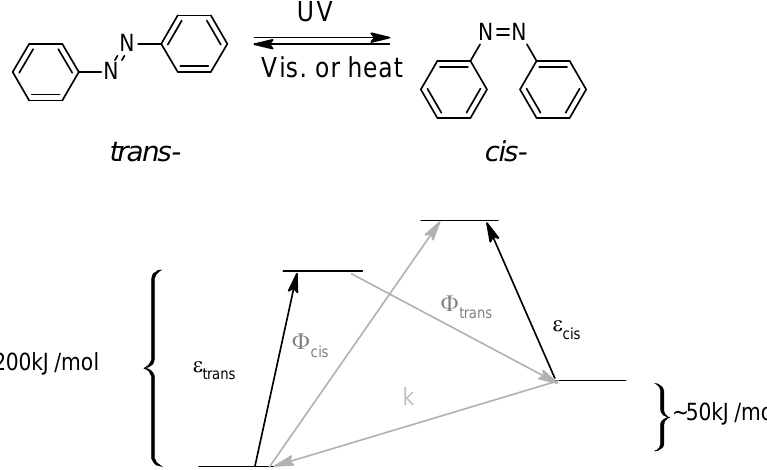
Figure 1. Isomerization capabilities of a nude azobenzene and simplified state model for a nude azobenzene. ε = extinction coefficients, Φ = quantum yields for the photoisomerization, k = rate of thermal